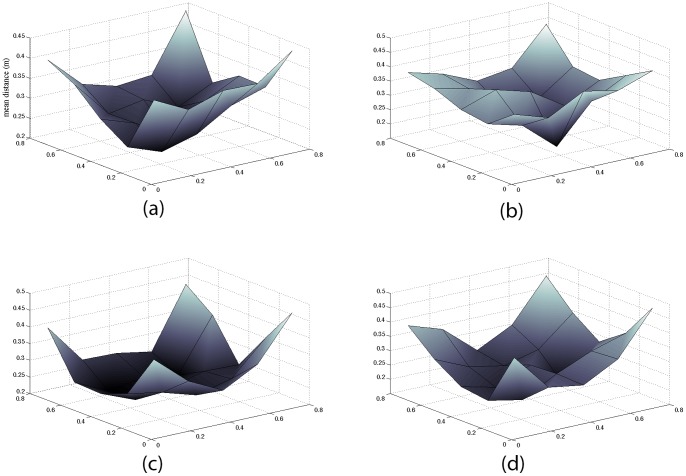
Distance between rat and robot by rat position.The vertical axis is the distance between the rat and robot corresponding to the position of the rat on the horizontal plane representing the rat arena. (a) Representing all 9 participants for rat A over trial 1 where the participants knew that the avatar represented a rat (b) The same participants for rat A over trial 2 where participants thought that the rat represented a remote human. (c) All 9 participants for rat B over trial 1. (d) The same participants over trial 2 for rat B.